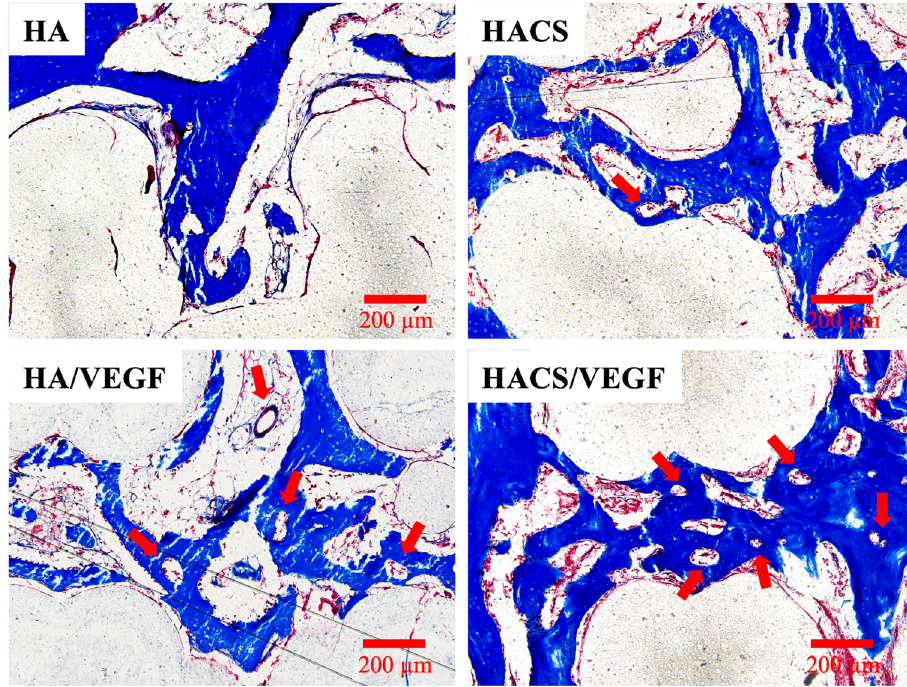
Figure 11. The higher magnification images of MT staining of regenerated bone mass after 8 weeks of regeneration for in vivo experiment. Red arrowheads indicate the blood vessels.